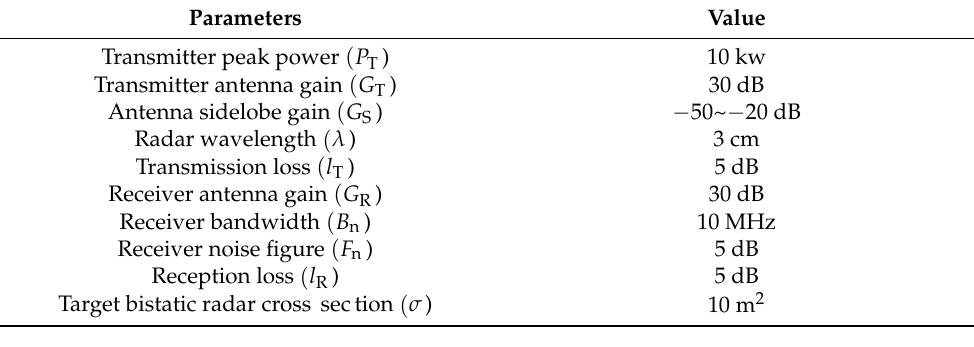
Table 1. Typical working parameters of the HBR system.